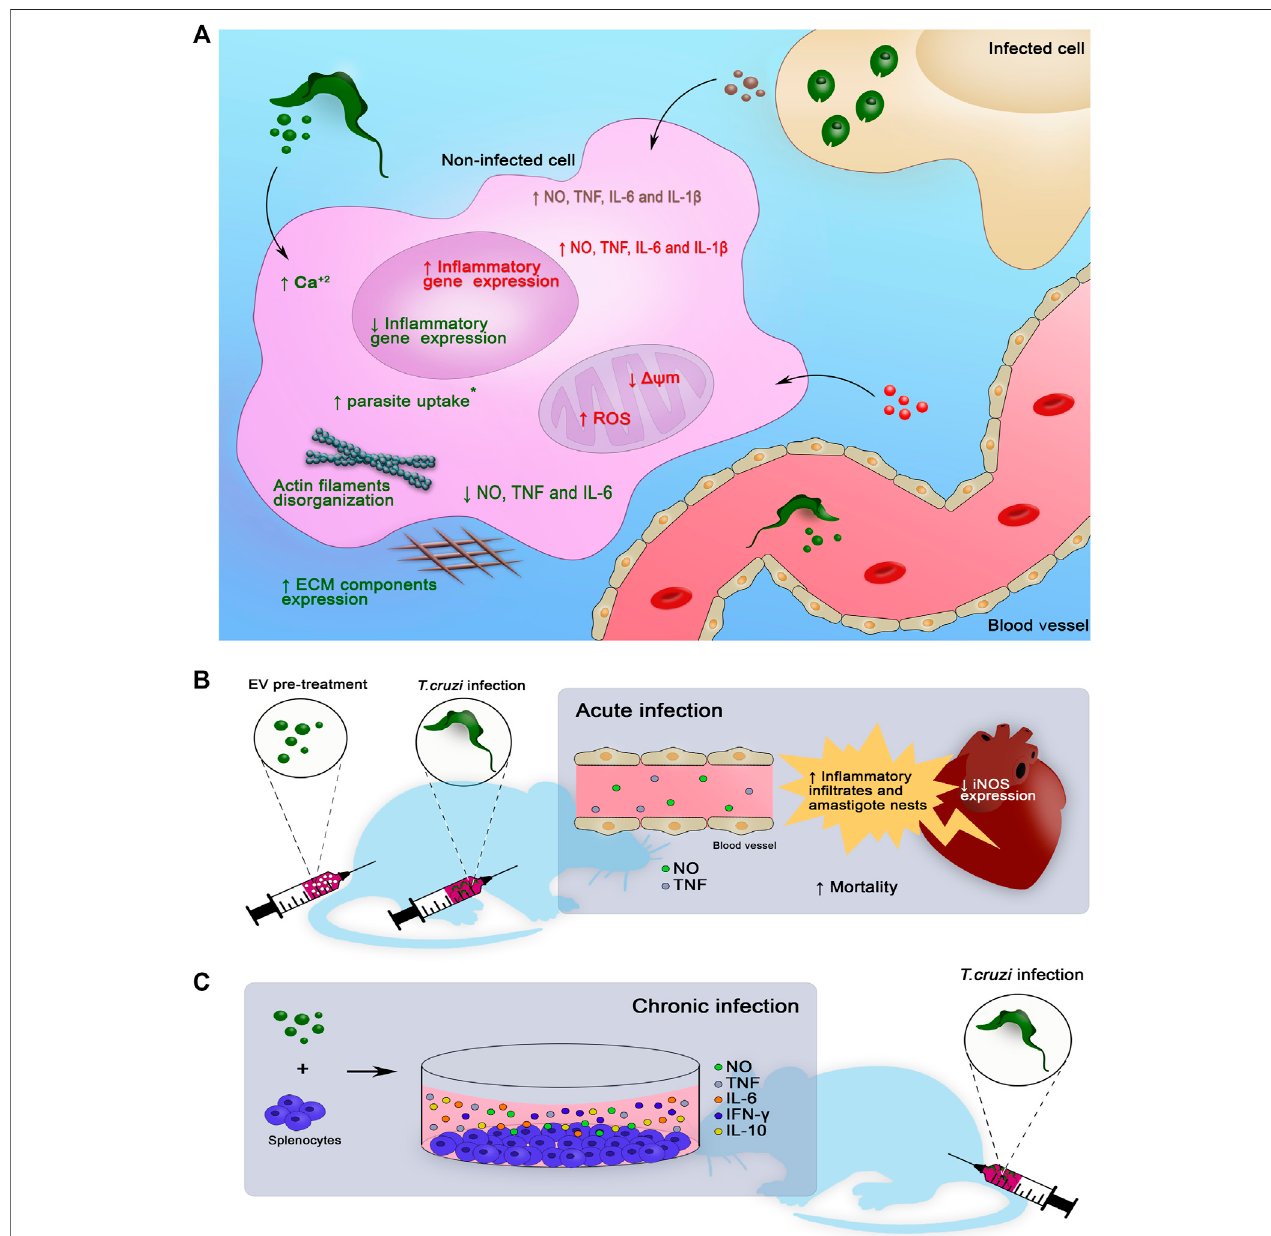
FIGURE 2 | Main regulatory activities of EVs from various sources in a scenario of Trypanosoma cruzi infection analyzed in vitro (A) , in vivo (B) and ex vivo (C) . (A) EVs released by the parasite have been shown to promote increased transient intracellular calcium levels (RetanaMoreiraet al., 2019) and actin fi lamentdisorganization (RetanaMoreiraetal.,2019),modulatetheexpressionofextracellularmatrixcomponents(Pinhoetal.,2002;RetanaMoreiraetal.,2019),reducethegeneexpressionof proin fl ammatorycytokines(Cronemberger-Andradeetal.,2020)andreducethereleaseofNO,TNF,andIL-6whenincontactwithuninfectedcells(Nogueiraetal., 2015; Lovo-Martins et al., 2018). The treatment with these EVs before infection with T. cruzi promotes an increase in parasite uptake in a target cell type-dependent manner (*) (Lovo-Martins et al., 2018). EVs released either by immune or nonimmune infected cells promote an increase in NO, TNF, IL-6, and IL-1 β levels in uninfected cells (Choudhuri and Garg, 2020a). EVs from the blood sources obtained from CD patients promote an increase in NO and IL-1 β release, increase mitochondrial ROS levels, and decrease mitochondrial membrane potential and in fl ammatory gene expression in EV-treated macrophages (Chowdhury et al., 2017). The treatment of macrophages with EVs obtained from the blood of mice with chronic infection increases TNF, IL-6, and IL-1 β release (Choudhuri and Garg, 2020a). (B) BALB/c mice pretreated with EVs from T. cruzi and challenged by infection have reduced NO and TNF levels in the serum in the acute phase (Trocoli-Torrecilhas et al., 2009; Lovo- Martins et al., 2018), reduced iNOS expression (Trocoli-Torrecilhas et al., 2009), increased number of in fl ammatory in fi ltrates and amastigote nests in heart tissue (Trocoli-Torrecilhas et al., 2009; Lovo-Martins et al., 2018), and increased mortality (Trocoli-Torrecilhas et al., 2009). (C) Splenocytes obtained from chronically T. cruzi - infected C57Bl/6 mice treated with parasite EVs showed increased NO, TNF, IL-6, IFN- γ , and IL-10 release (Nogueira et al., 2015), contributing to the idea that EVs participate in CD pathogenesis.